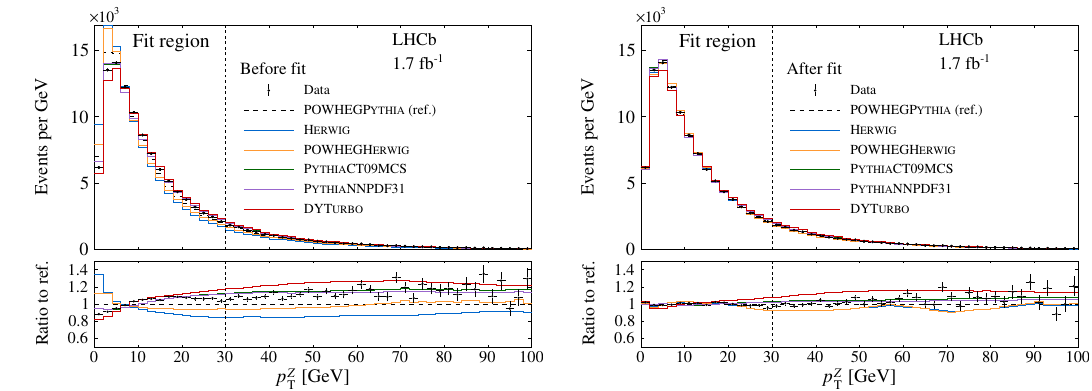
(left) before and (right) after the fit for the different candidate Figure 7 . Distributions of p Z T models of the unpolarised cross-sections. The fit only considers the region p Z by the dashed vertical line. In the lower panels the ratios with respect to the POWHEGPythia model are